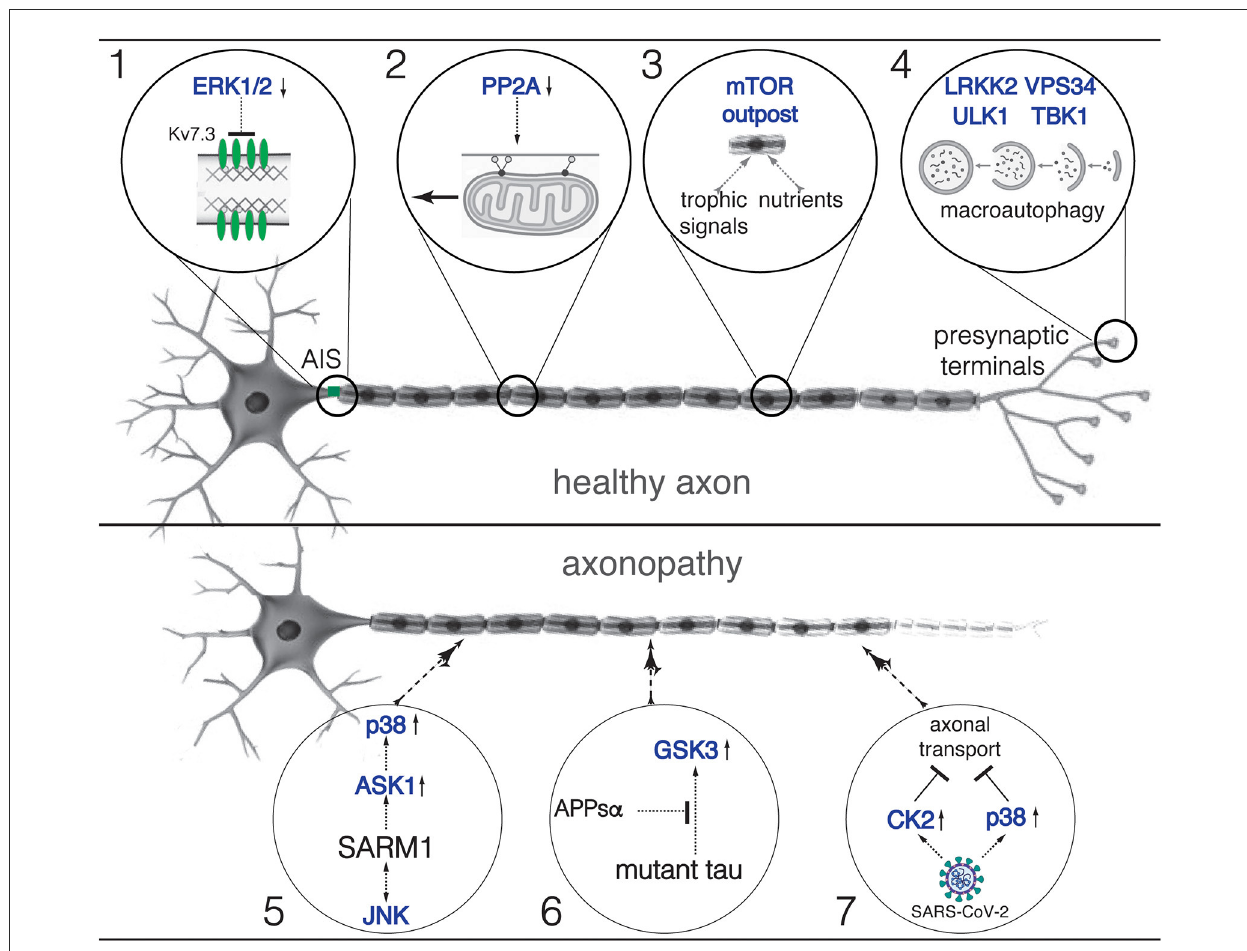
FIGURE1 Roles of specific protein kinases, phosphatases and phosphorylation-based mechanisms on axonal function and pathology. Schematic representation of mature motor neurons bearing a healthy (top) and a degenerating axon (bottom) . Circles 1 to 7 provide a succinct summary of kinases, phosphatases (both indicated by text in blue), and phosphorylation-based mechanism addressed by each manuscript in this Research Topic [1: see Baculis et al.; 2: see Heo et al.; 3: see Altas et al.; 4: see Berth et al.; 5: see Waller and Collins; 6: see Baltissen et al.; 7: see Richards and Jaesnich]. Small arrows pointing up and down indicate heightened and reduced kinase/phosphatase activities, respectively. Inhibitory effects are indicated by blunt arrows. Within each circle, dashed lines indicate that specific effects might be